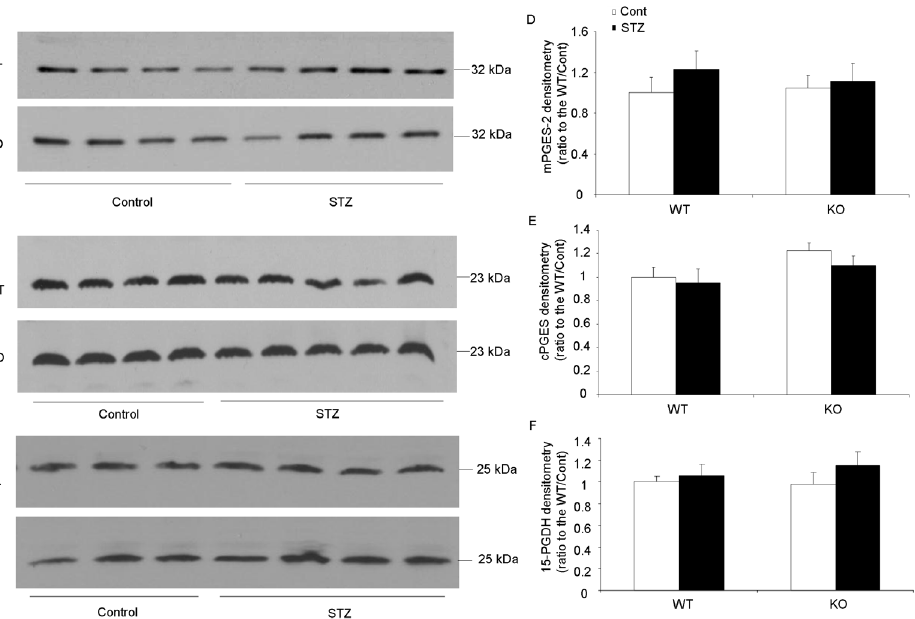
Figure 5. Protein expressions of mPGES-2, cPGES and 15-PGDH in diabetic mice. (A) mPGES-2 protein analysis by Western blotting (N=4 per group). (B) cPGES protein analysis by Western blotting (N=4–5 per group). (C) 15-PGDH protein analysis by Western blotting (N=3–4 per group). (D) Densitometry analysis of mPGES-2 Western blotting. (E) Densitometry analysis of cPGES Western blotting. (F) Densitometry analysis of 15-PGDH Western blotting. Data are mean 6 SE.